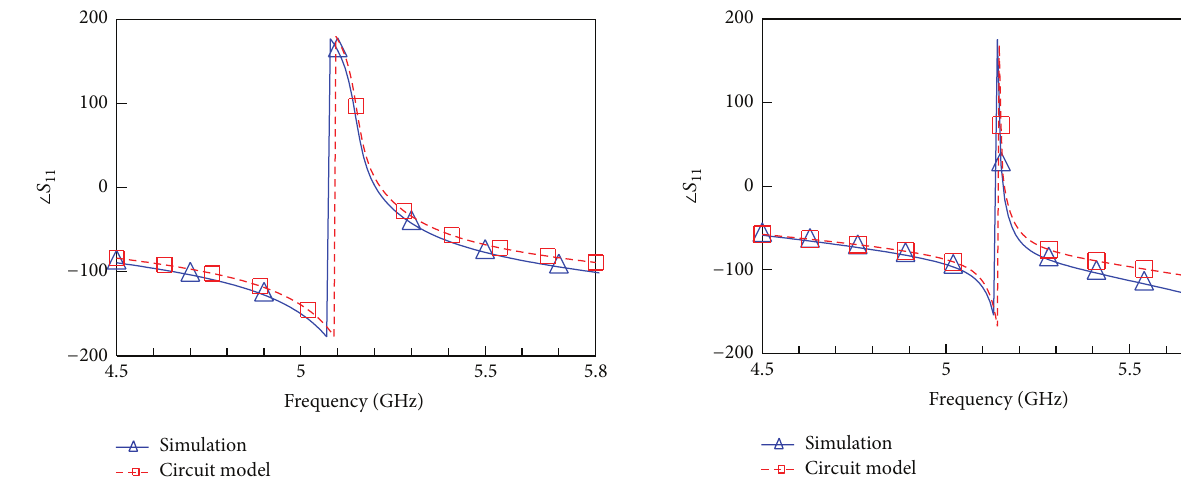
Figure 22: Comparison of circuit model and simulated phase of reflection coefficient results of miniaturized patch antenna loaded with